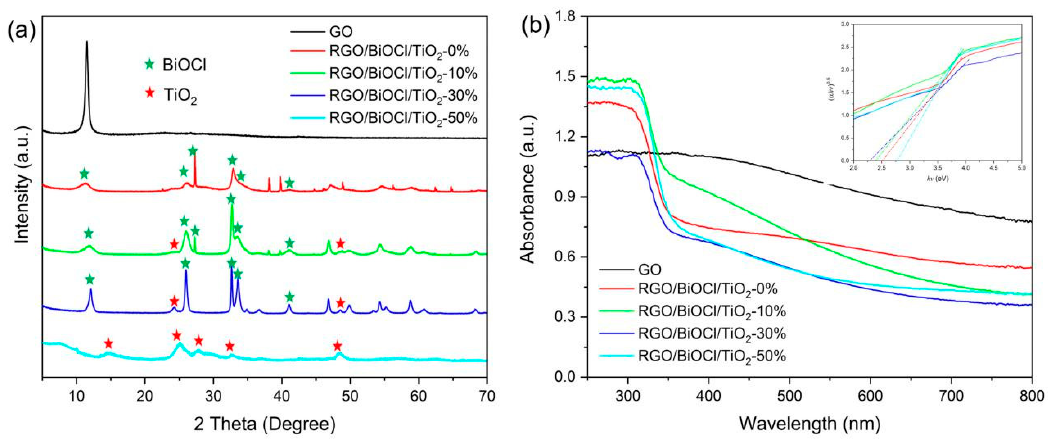
Figure 5. ( a ) XRD patterns and ( b ) UV–vis diffusive reflectance spectra of as-prepared